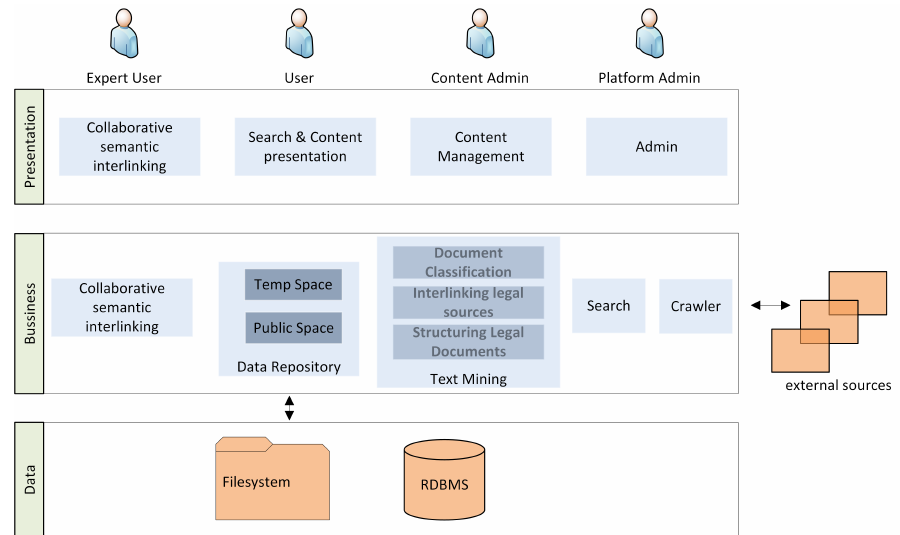
Figure 4. High-level view of Solon logical and conceptual architecture